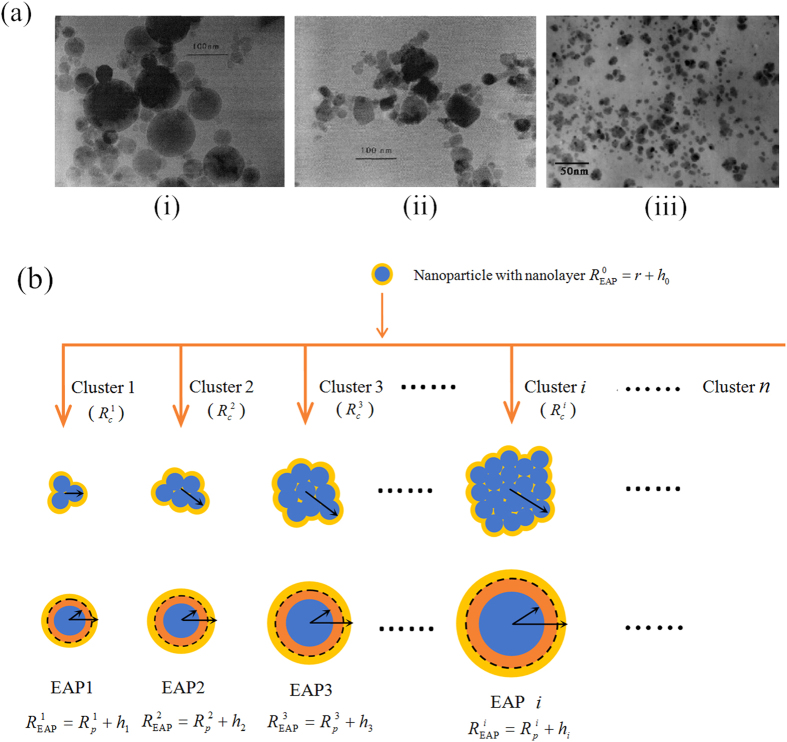
TEM of nanofluids and the schematic cross section of model.(a) The TEM of nanofluids. (i) is the TEM for /water25, we estimate agglomeration ratio ; (ii) is CuO/water25, we estimate the agglomeration ratio ; (iii) is Cu/ethylene glycol39 without agglomeration. (b) The schematic cross section of multilevel equivalent agglomeration model.